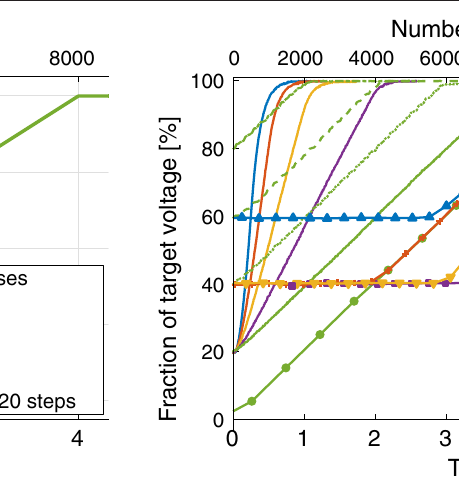
FIG. 1. Theoretical voltage increase in each of the ramping scenario in the first set of measurements as a function of time and the number of pulses. With the repetition rate of 2000 Hz, one second equals 2000 pulses. The figure also contains a 20 step ramping scenario used in Refs. [24,28] for comparison.